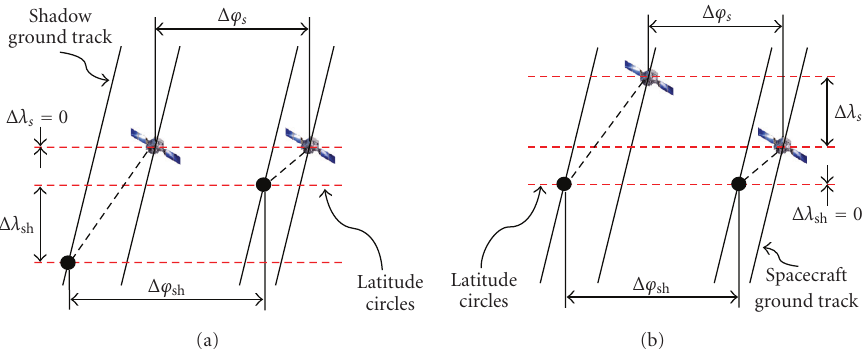
Figure 11: Latitude and longitude changes for both shadow and spacecraft ground track after: (a) spacecraft nodal period τ , (b) shadow nodal period τ sh .